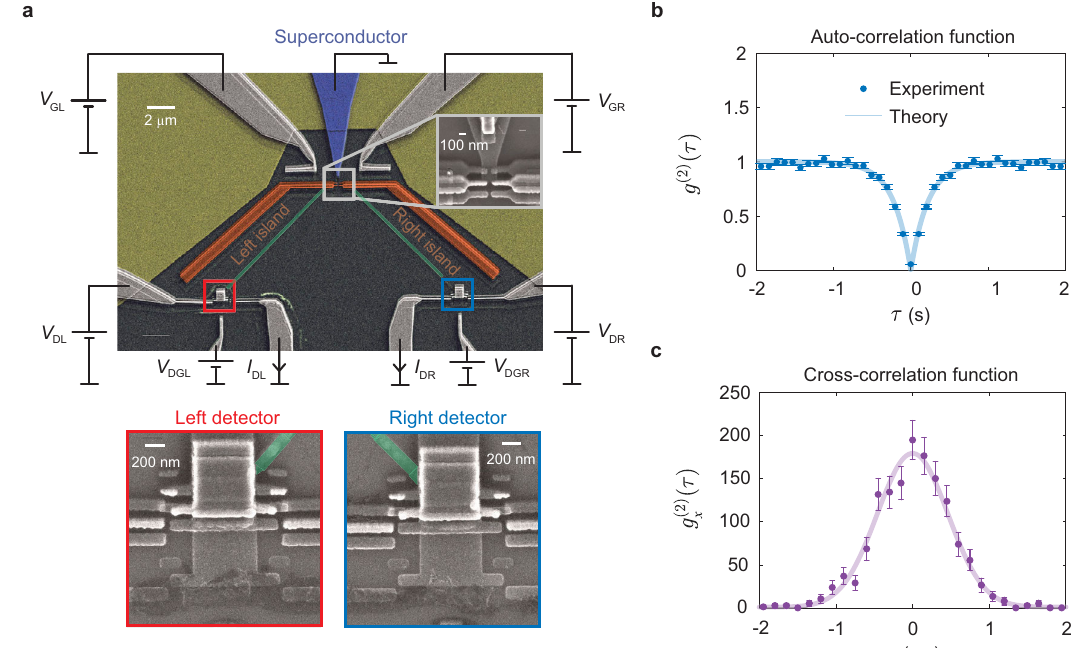
Fig. 1 Cooper pair splitter and correlation measurements. a Scanning electron micrograph of the grounded superconducting reservoir (colored blue) coupled via tunnel junctions to two normal-state metallic islands (in orange). The voltages V GL and V GR are connected to gate electrodes and tuned to control the electronic populations on the islands. Each island is capacitively coupled via a metal strip (in green) to a single-electron transistor, which serves as a real-time charge detector to read out the number of electrons on each island from the measured signals I DL and I DR . The detectors are biased by the voltages V D α ( α = L or R ) and gated by the voltages V DG α . The inset in the upper right corner shows the tunnel junctions that connect the superconductor to the two metallic islands. b Measurements of the auto-correlation function g (2) for single-electron tunneling into the right island with a time delay τ between tunneling events. The correlation function is suppressed at short times due to the strong Coulomb interactions on the island, which lead to anti-bunching. for transitions between the superconductor and the left island at the time t = 0, followed by transitions between the c Cross-correlation function g ð 2 Þ x superconductor and the right island at the time t = τ . The cross-correlations are strongly enhanced for short times due to crossed two-electron processes such as Cooper pair splitting and elastic cotunneling between the islands via the superconductor. The error bars in ( b , c ) are given by the standard deviations. Details of the device fabrication and the measurements are provided in “ Methods ”